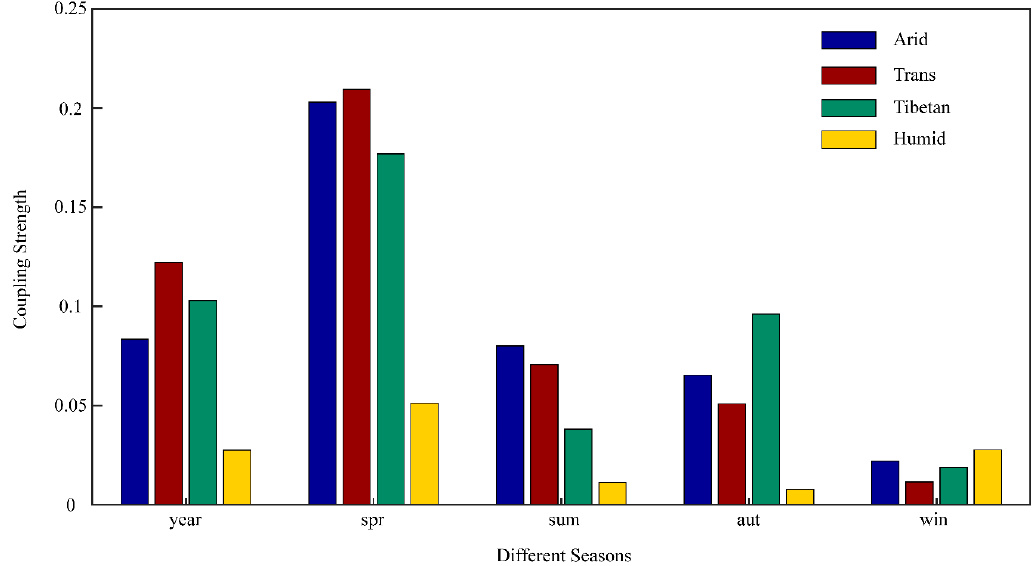
Figure 3. Soil moisture–temperature coupling strengths in different seasons in the typical climate regions over China during the period 1980–2013.